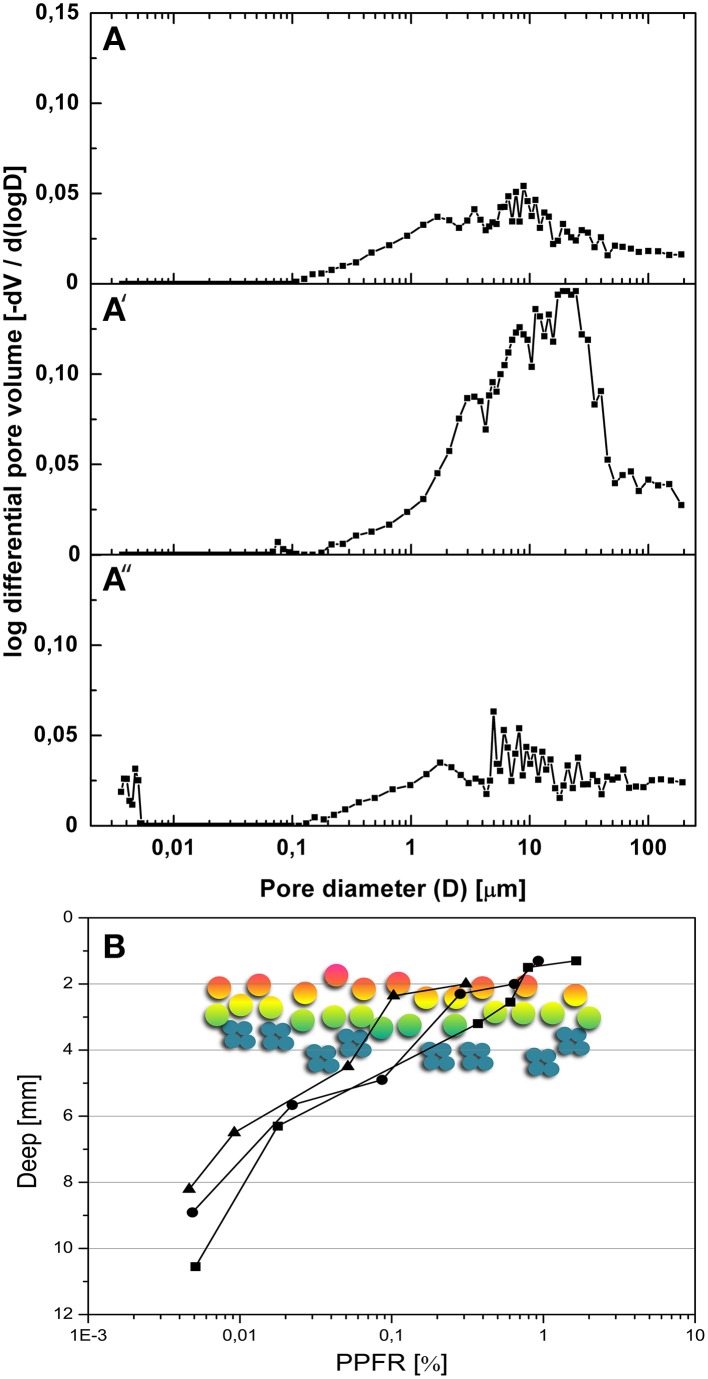
Porosity and light transmission properties of gypsum deposits. (A–A″) pore size distribution curves for surface layer (A), interior (A′) and bottom layer (A″); mean curves for four samples. (B) Intensity of photosynthetic photon fluence rate (PPFR) within gypsum wet deposits at different depths (n = 3); hypothetical position of cryptoendolithic colonization zone is shown by the schematic positioning of green-orange algae (circles) and cyanobacteria (small cyan discs).